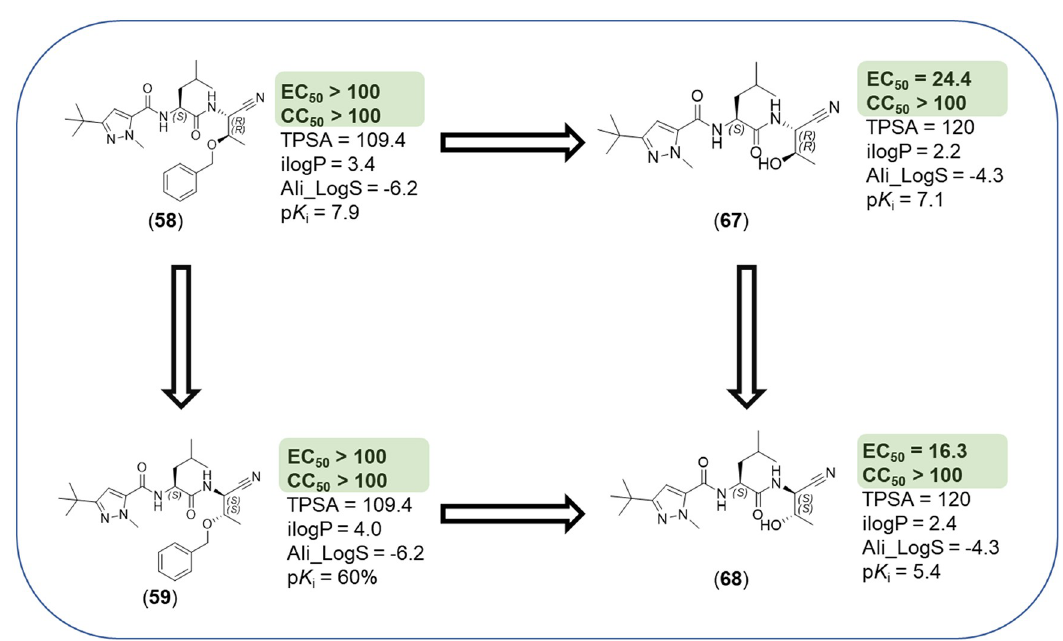
Fig 14. Schematic representation for non-additivity of SARs for compounds 58, 59, 67 and 68. EC 50 calculated for amastigote forms of T . cruzi (Tuhaluen strain). CC 50 calculated for the LLCMK2 strain (host cell). Green areas highlight biochemical results. TPSA, ilogP, and Ali_Logs have been calculated with the swissADME online service [35]. p K i values are referring to Cz